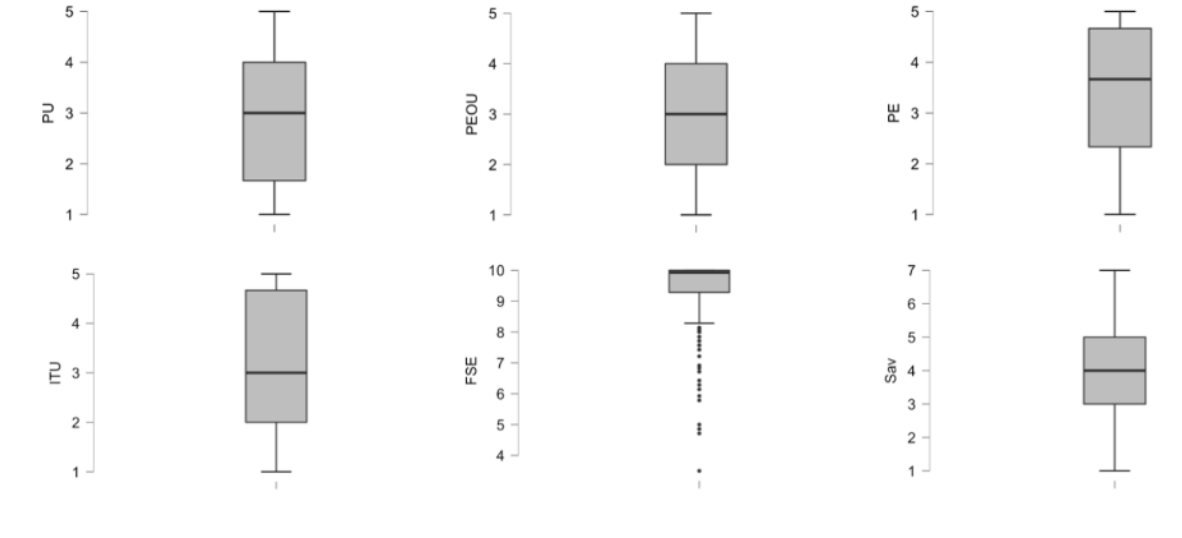
Figure 2. Boxplots for all variables. FSE: fall-related self-efficacy; ITU: intention to use; PE: perceived enjoyment; PEOU: perceived ease of use; PU: perceived usefulness; Sav: self-avoidance